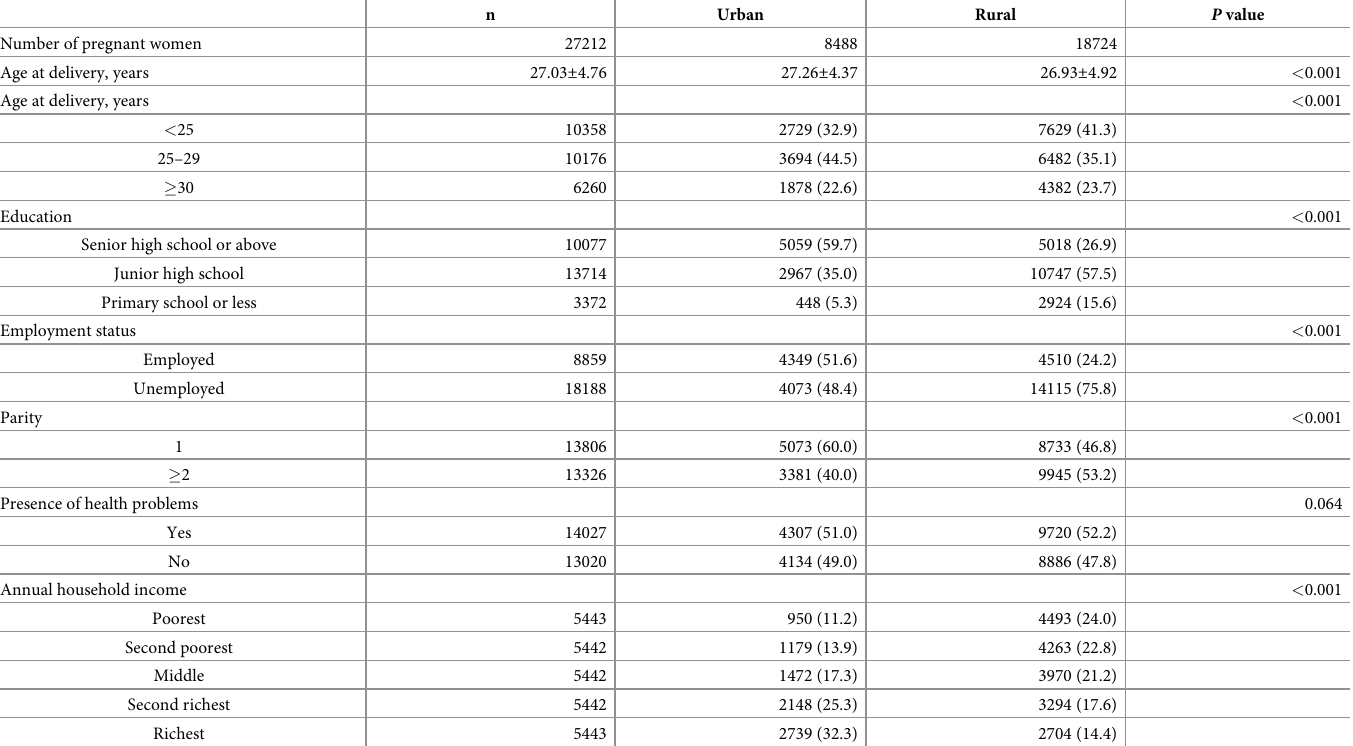
Table 1. Baseline characteristics of pregnant women by urban and rural